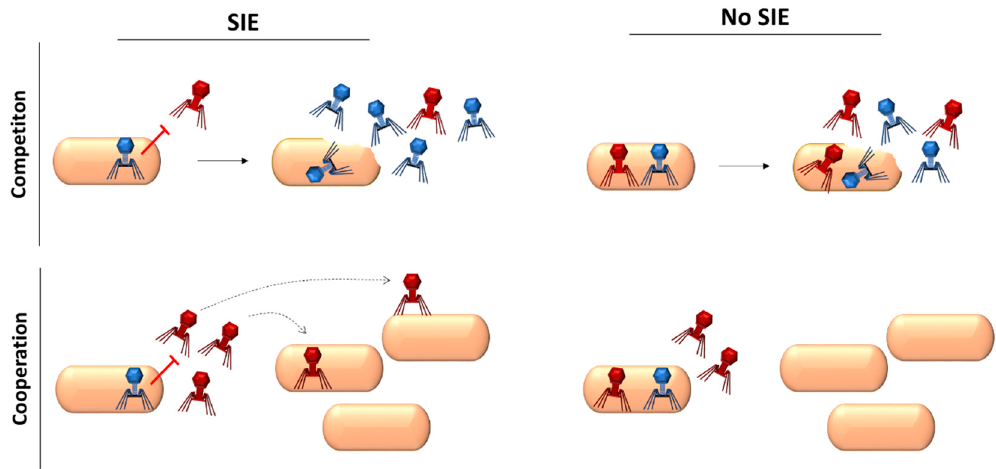
Figure 4. Two possible evolutionary interpretations of superinfection exclusion (SIE). Superinfection exclusion could be considered as a mechanism for avoiding competition for intracellular sources. In this scenario, superinfection exclusion would directly increase the fitness of the actor virus, which would capitalize on cellular resources at the expense of the excluded virus. Alternatively, superinfection exclusion could be considered as a cooperative mechanism whereby the actor virus would pay the cost of promoting the spread of the excluded virus (indicated by dotted arrows) to uninfected neighbor cells, which would improve overall resource exploitation.